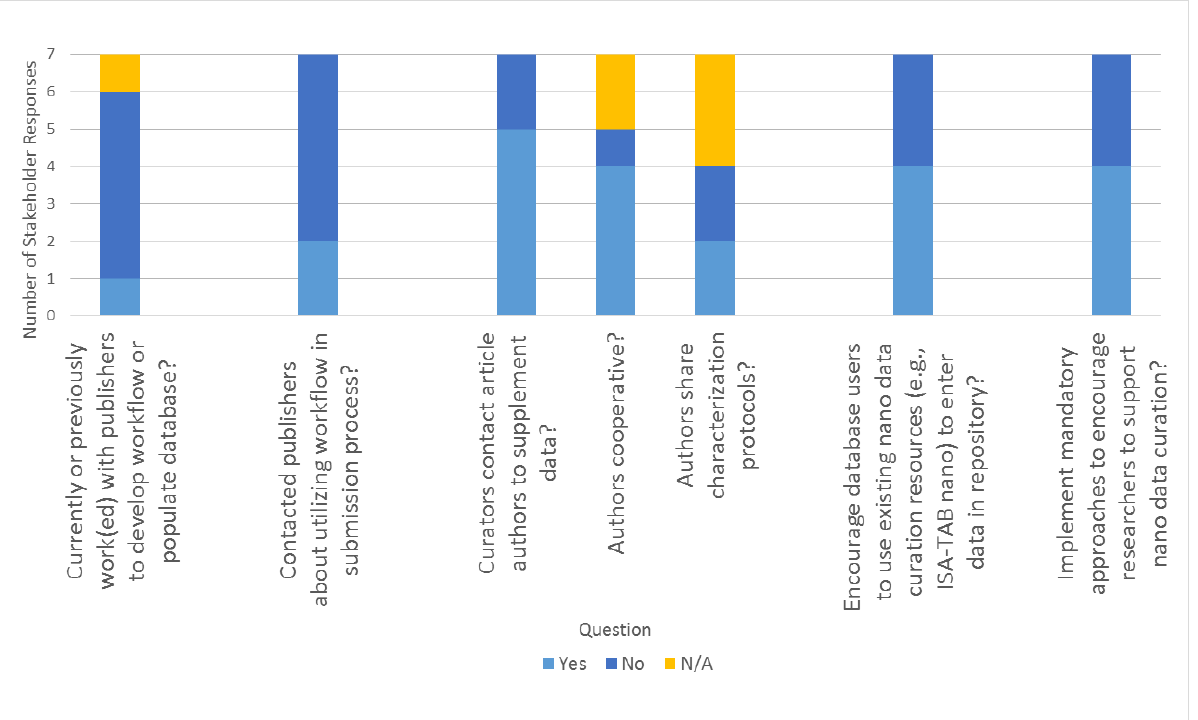
Figure 5: Stakeholder responses regarding working with other organizations. Stakeholder responses to questions related to interacting with other organizations to develop a workflow or populate a data repository. In each panel, the response categories (e.g., “yes”, “no”, “N/A”) for each question are provided in the legend. Questions are listed on the x-axis and the number of stakeholders responding in each category is on the y-axis. Full text of stakeholder responses is available in Supporting Information File